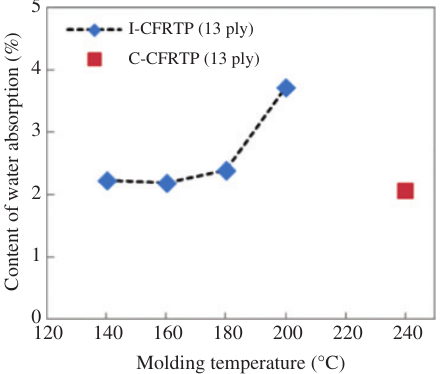
Figure 7 Content of unreacted monomer of I-PA6 and C-PA6 and of I-GFRTP and C-GFRTP.